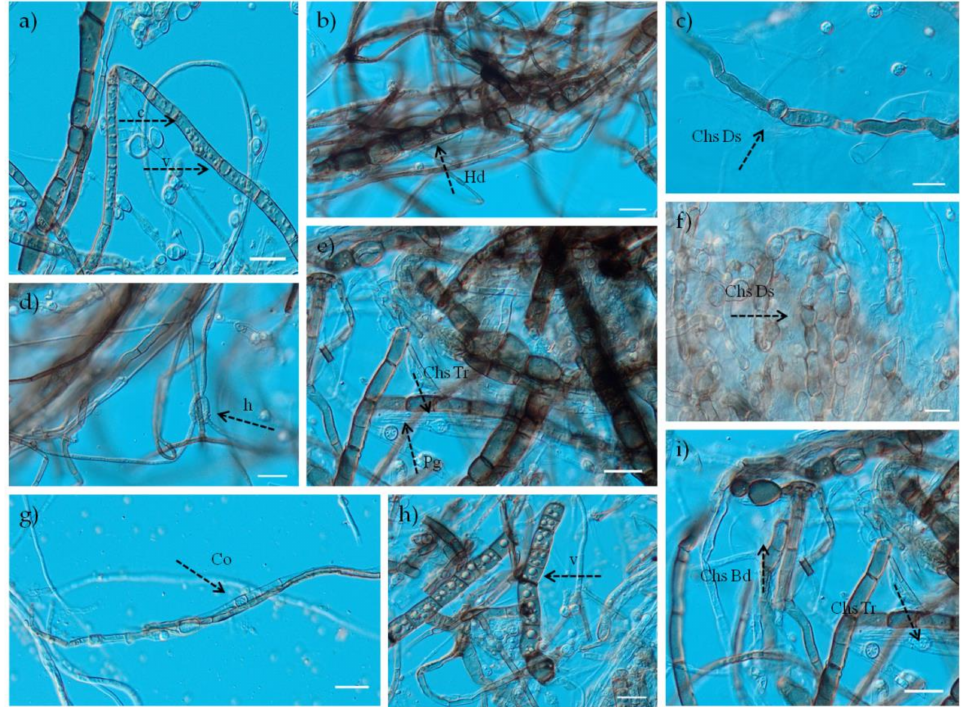
Figure 3. Observations of mycelial interactions between Trichoderma spp. and B. dothidea and